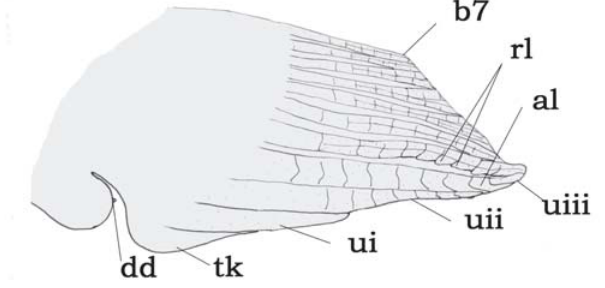
Fig. 35. Male modified anal fin of Tatia neivai , MZUEL 206, 56.0 mm SL. Left side lateral view. Abbreviations: ac , antrorsely curved denticulation; b7 , branched seventh ray; dd , deferent duct; rc , retrorsely curved denticulation; tk , tegumentary keel; ui , unbranched first ray; uii , unbranched second ray; uiii , unbranched third ray. Scale bar = 1.0